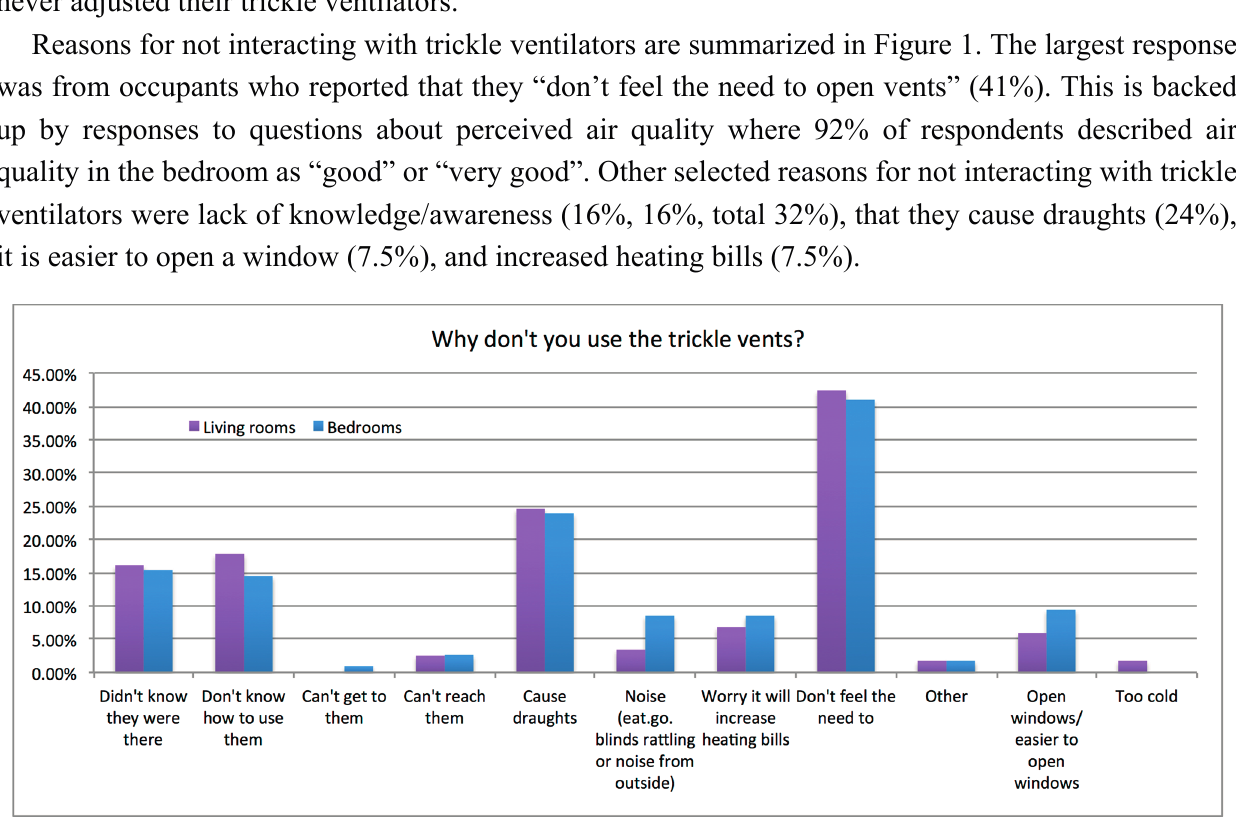
Figure 1. Barriers to trickle ventilators use, living rooms and